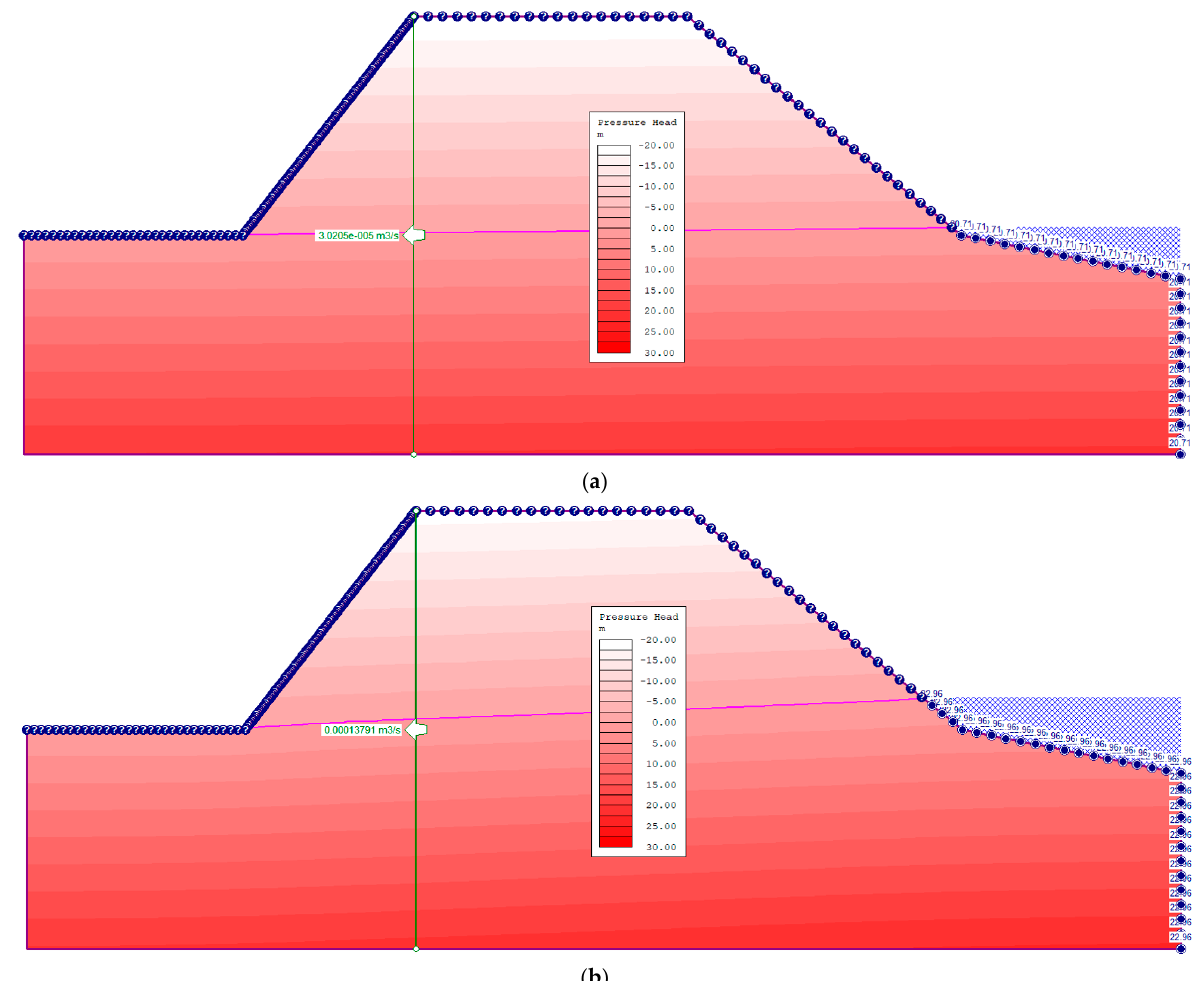
Figure 10. Pore pressure within the slopes at low and high tides (20 m excavation depth 50 m from shoreline). ( a ) Low tide level 0.71 m; ( b ) high tide level 2.96 m. A parametric analysis was conducted on the variation in ocean ‐ water seepage with excavation depth and distance from the shoreline. The nephograms in Figure 11 show the various pore pressure plots. At the same distance from the shoreline, the pore pressure in the slope and discharge velocity increase with increasing excavation depth. On the other hand, when the excavation depth is held constant, the discharge velocity decreases with increasing distance from shoreline and the pore pressure intensity also reduces. An obser ‐ vation of the trend of the phreatic surface shows that the farther the slope face is from the shoreline, the smaller the slope section exposed to ocean ‐ water intrusion.